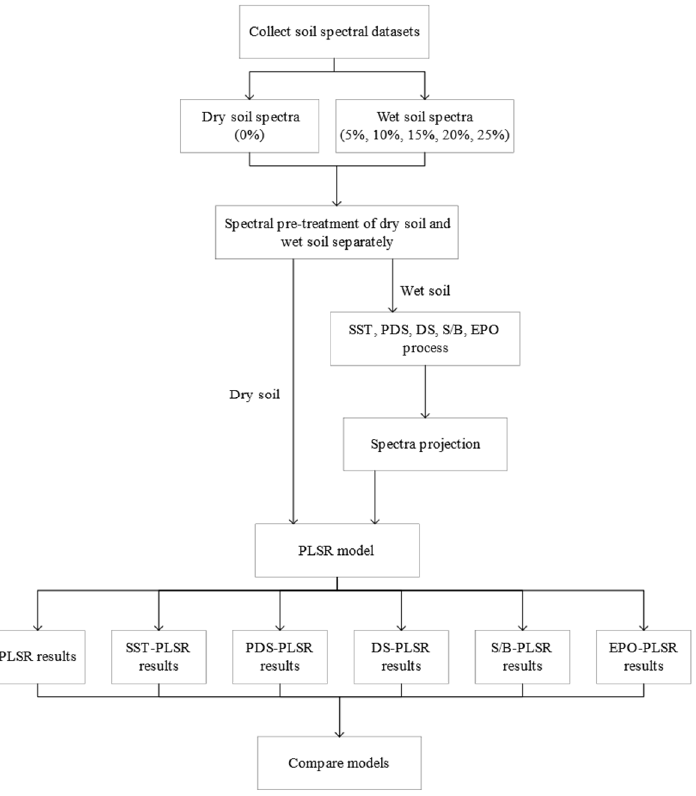
Figure 2. The flowchart illustrates the different steps performed during model calibration and wet and dry soil spectral data validation.